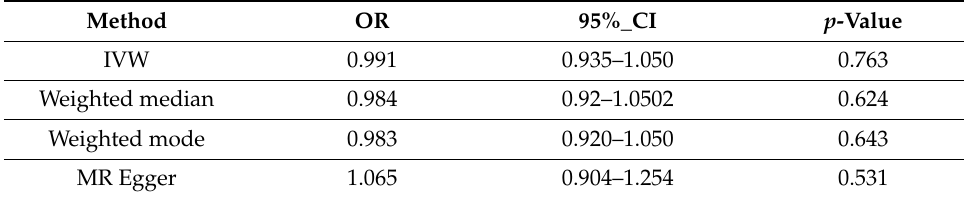
Table 1. Results of the MR sensitivity analysis using 4 African 25OHD